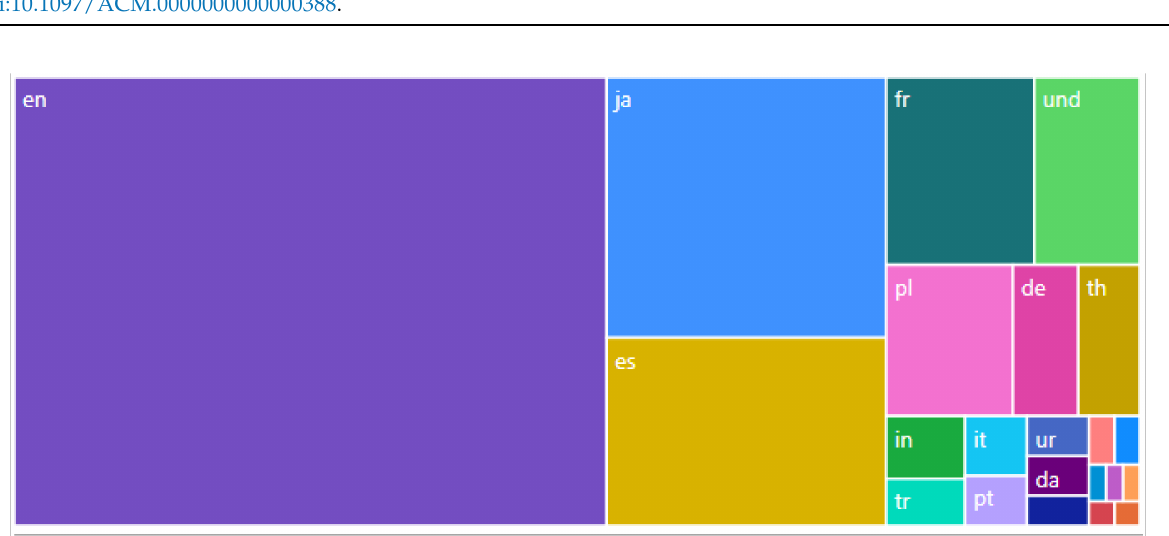
Figure A1. Treemap of language of COVID-19-related Tweets of toilet paper in March